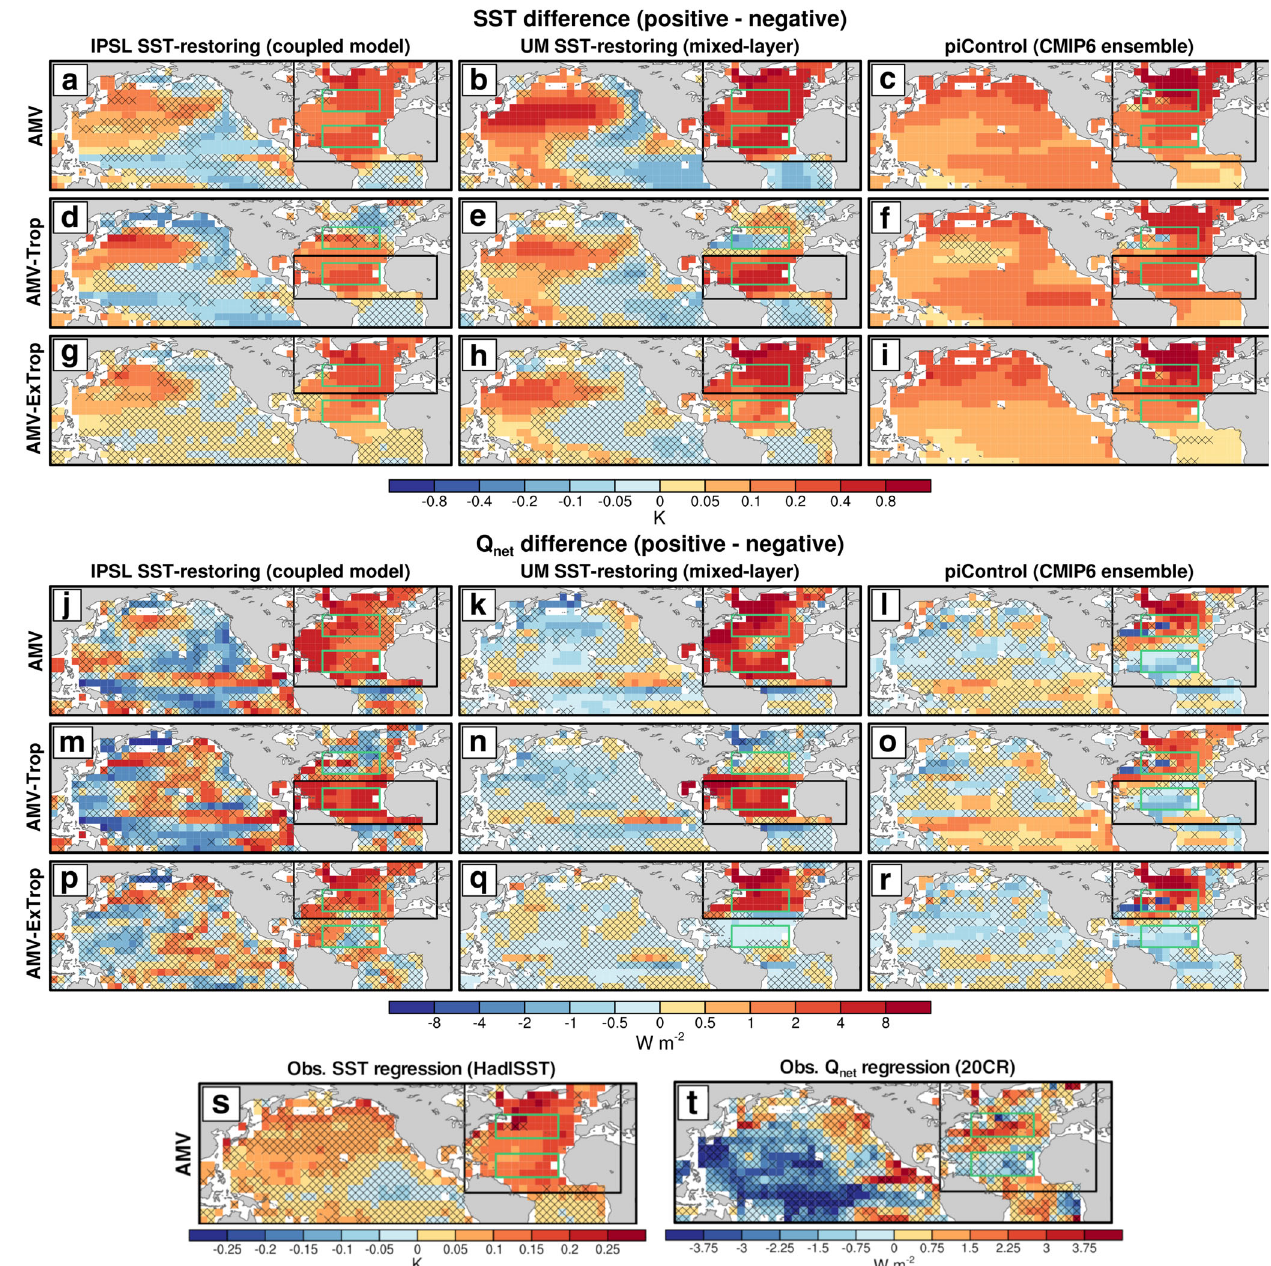
Fig. 1 The dependence of SST and surface heat- fl ux on AMV phase. a – i SST difference between SST + and SST- 10-year periods for the AMV, AMV-Trop and AMV-ExTrop regions (indicated by the black boxes). These are shown for the SST-restoring experiments for the IPSL and UM models; for the free-running coupled PiControl simulations the SST + and SST- decades are decades in which the SST in the region is above/ below one standard deviation from the mean. j – r Surface heat- fl ux, Q net (de fi ned as positive upwards), difference between SST + and SST- 10- year periods for the AMV, AMV-Trop and AMV-ExTrop regions. Hatching indicates where the differences are not signi fi cant at the 95% level, based on a Monte Carlo resampling performed 10000 times (see Methods). s Decadal SST anomalies (HadISST, 1870-2014) and ( t ) Q net anomalies (20CR, 1870 – 2014) regressed onto a normalised decadal SST index averaged over the AMV region. Hatching in ( s, t ) indicates where the regression coef fi cients are not signi fi cant at the 95% level, based on a Monte Carlo phase randomisation test (see Methods). The green boxes indicate the midlatitude and subtropical North Atlantic regions used in Fig. similar across all three index regions over the North Atlantic (Fig. albeit largely by design over the North Atlantic. In the AMV and 1c, f, h) and are most similar to the AMV and AMV-Extrop SST- AMV-ExTrop experiments, the SST differences are signi fi cantly restoring simulations. The differences in the free-running piCon- positive across the entire North Atlantic (Fig. 1a, b, g, h), whereas trol simulations are also similar to the observed SST anomaly in the AMV-Trop experiments the positive differences are mostly pattern associated with the AMV, which are shown in Fig. 1s (and limited to the subtropical region in which the relaxation is applied is similar for all regions and is also similar in the CMIP6 Historical (Fig. 1d, e). The difference between the analogous positive and simulations; Supplementary Fig. 2). negative periods in the free-running piControl simulations are